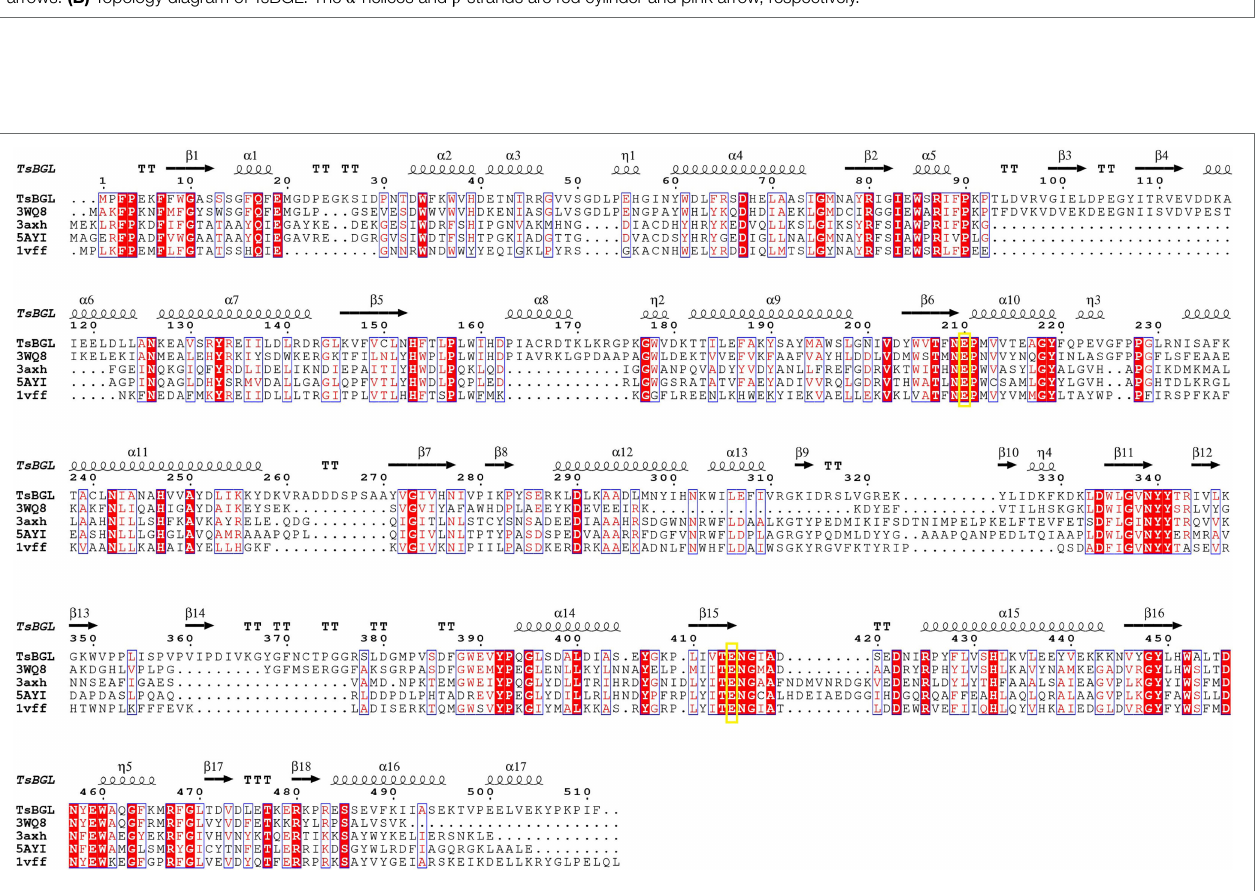
FIGURE 4 | Multiple sequence alignment of TsBGL with other GH1 family β -glucosidases (BGLs), 3AXH from Clostridium cellulovorans , 3WQ8 from Pyrococcus furiosus , 1VFF from Pyrococcus horikoshii , and 5AYI isolated from a compost